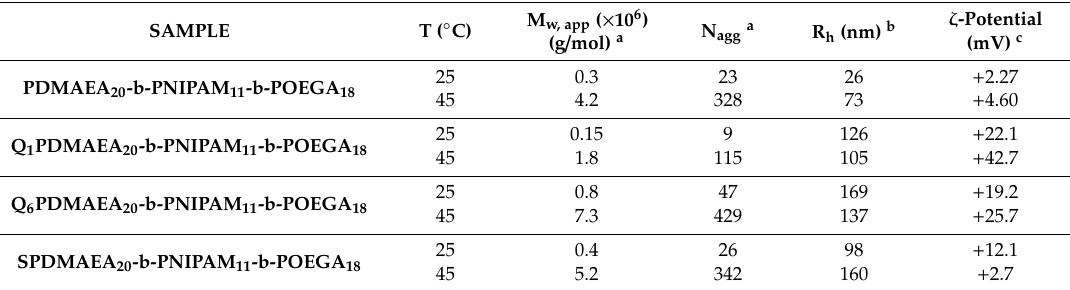
Table 2. Light scattering results for triblock amine terpolymers and their chemically modified analogues at neutral pH and at selected